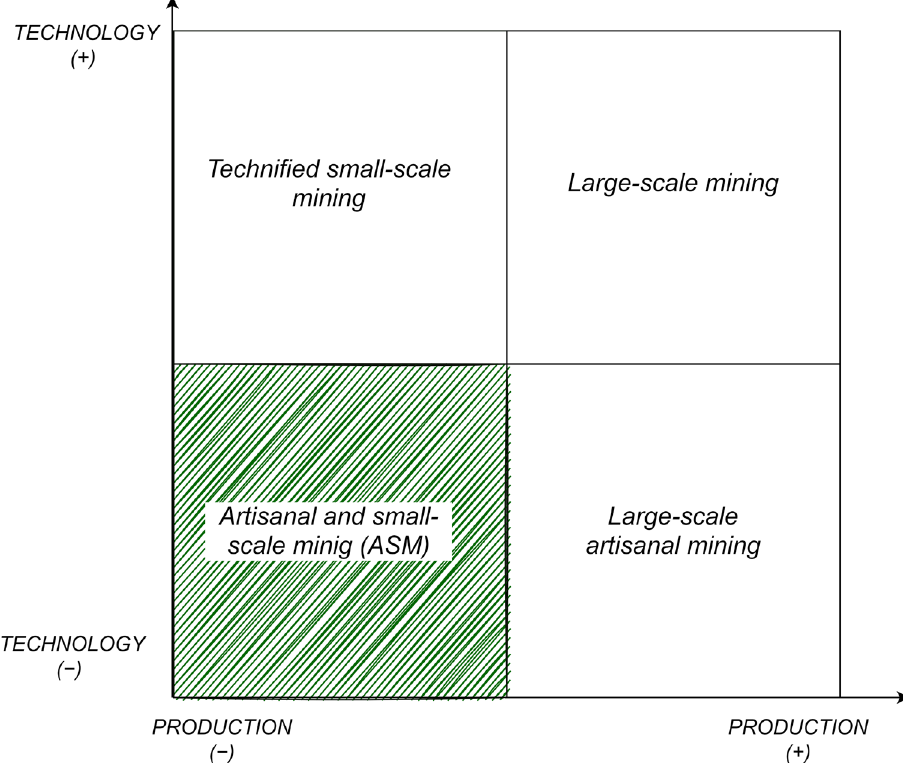
Figure 1. Schematic representation of ASM as a term that unites SSM and